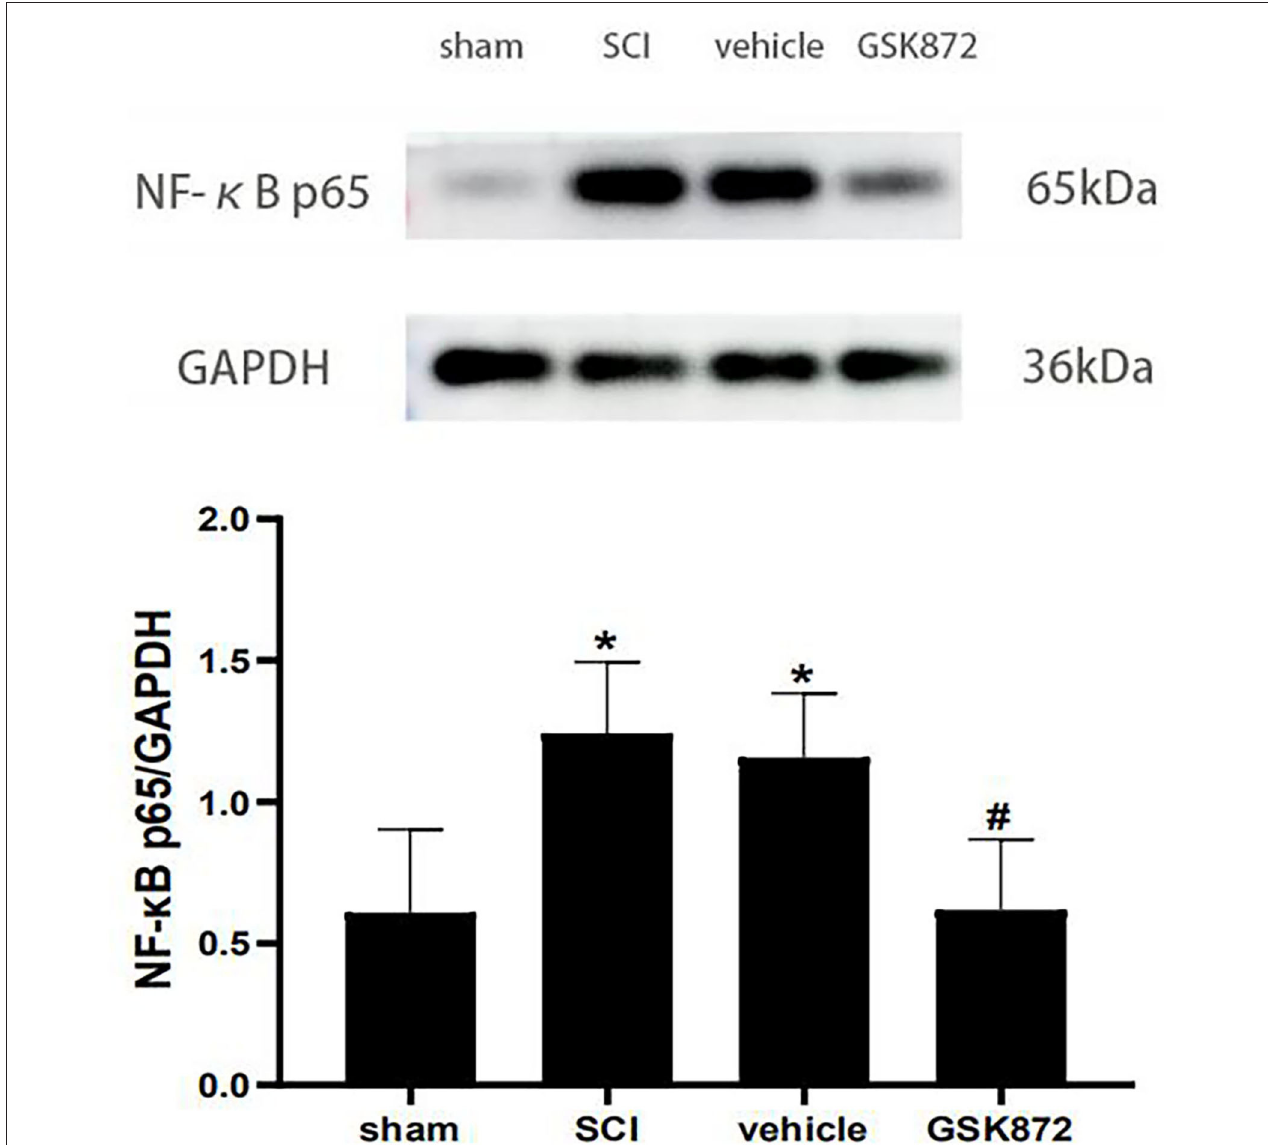
FIGURE 6 | Intrathecal injection of GSK872 (10 µ l, 25 mmol/L) inhibited NF- κ B p65 in the lumbar spinal dorsal horns ( n = 5 for each group). The expression of NF- κ B p65 in different groups, including sham, SCI, vehicle and GSK872 group, was measured by western blot analysis. All data were calculated as mean ± SD. * p < 0.05 vs. the sham group. # p < 0.05 vs. the vehicle group. Comparisons between multiple groups were carried out by one-way ANOVA and Turkey’s post-hoc analysis. NF- κ B, nuclear factor-kappa B.